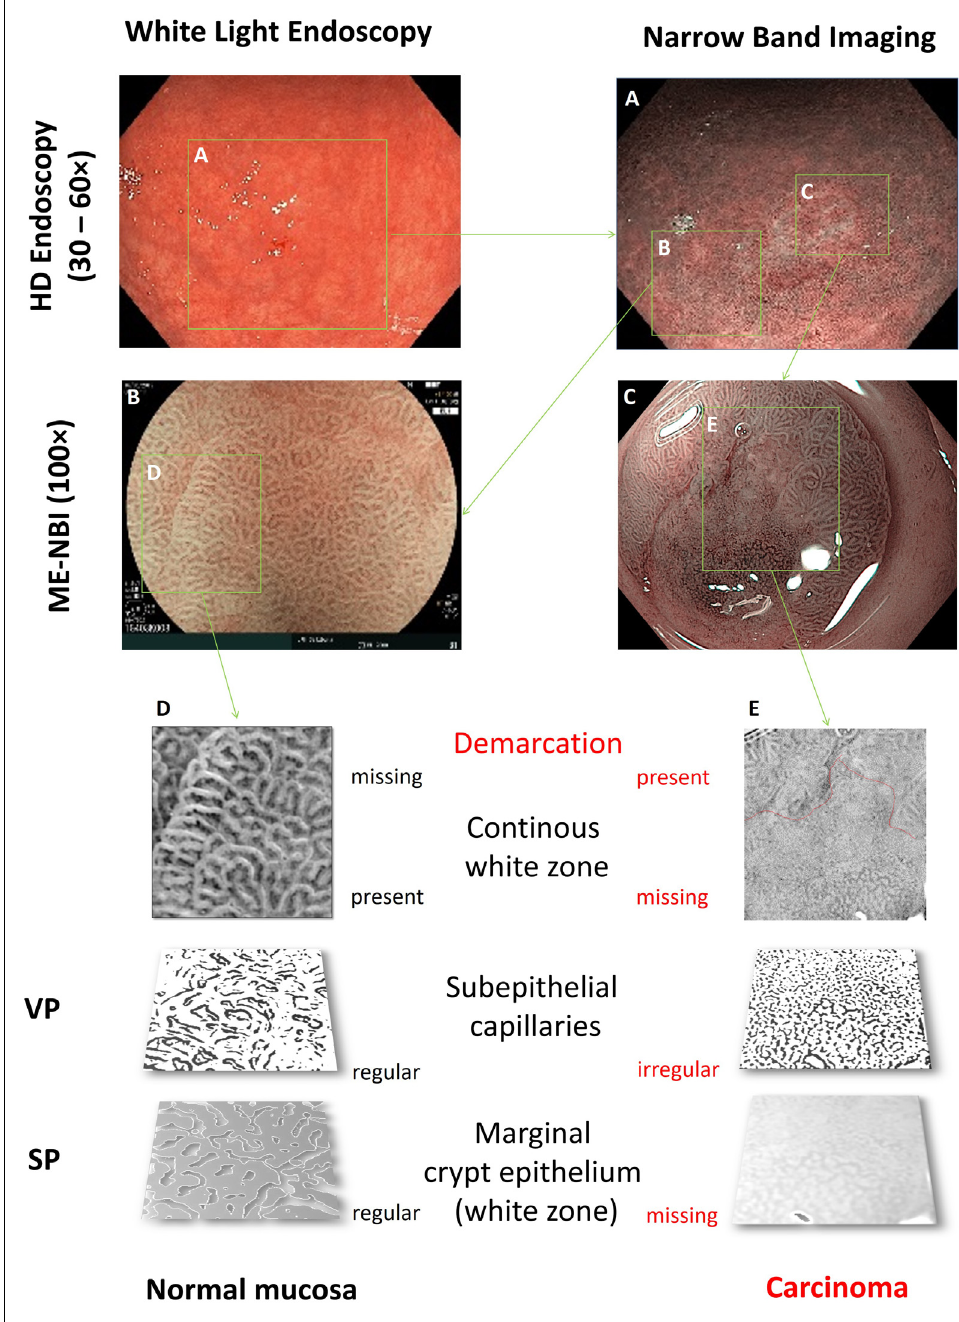
Figure 3. Optical endoscopic characterization of a gastric lesion (antrum). ( A ): The lesion is merely demarcated in white light HD endoscopy. Magnification endoscopy (ME) with narrow band imaging (NBI) allows for characterization of normal vs. cancerous areas in the antrum ( B , C ). Determining factors are demarcation and presence of a white zone. Vascular pattern (VP) is determined by the pattern of subepithelial capillaries, and surface pattern (SP) by the marginal crypt epithelium (i.e., the “white zone”), respectively ( D , E ).